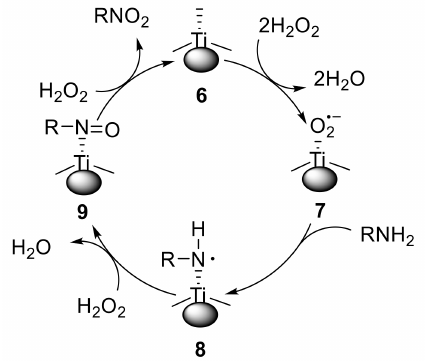
Figure 1. Proposed catalytic cycle for the oxidation of